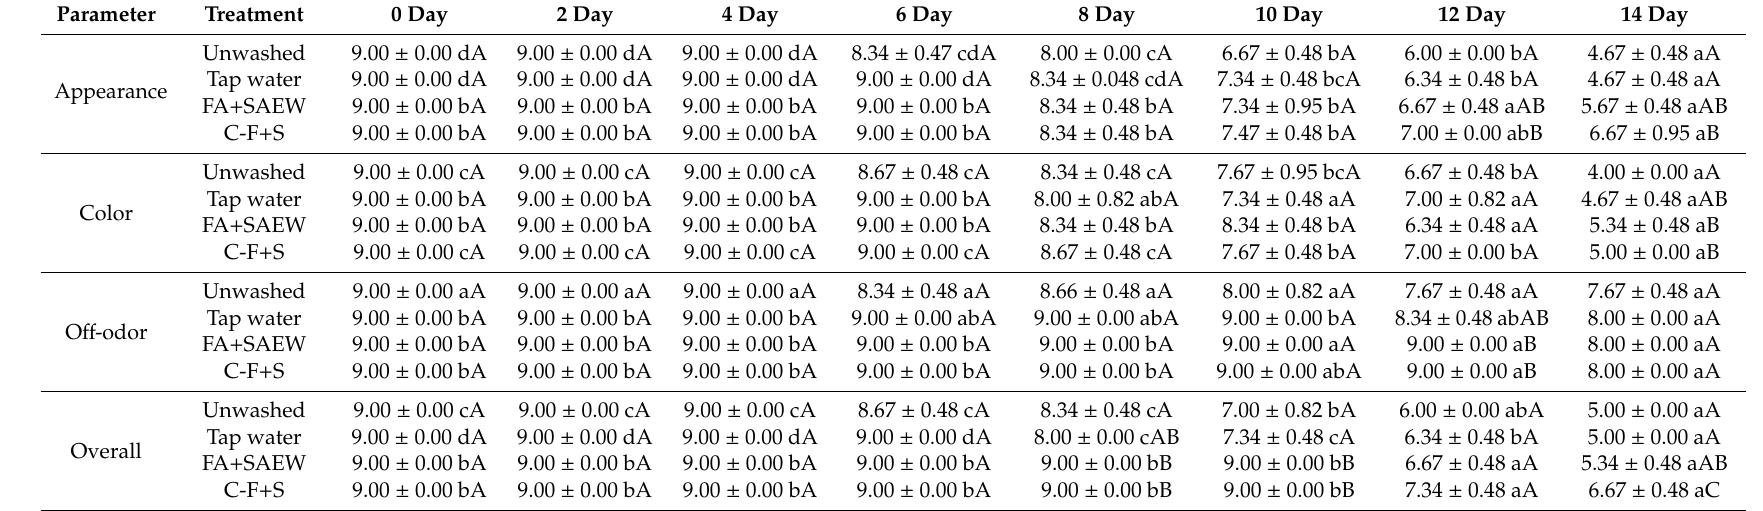
Table 1. Sensory quality changes of fresh apple during storage at 4 ◦